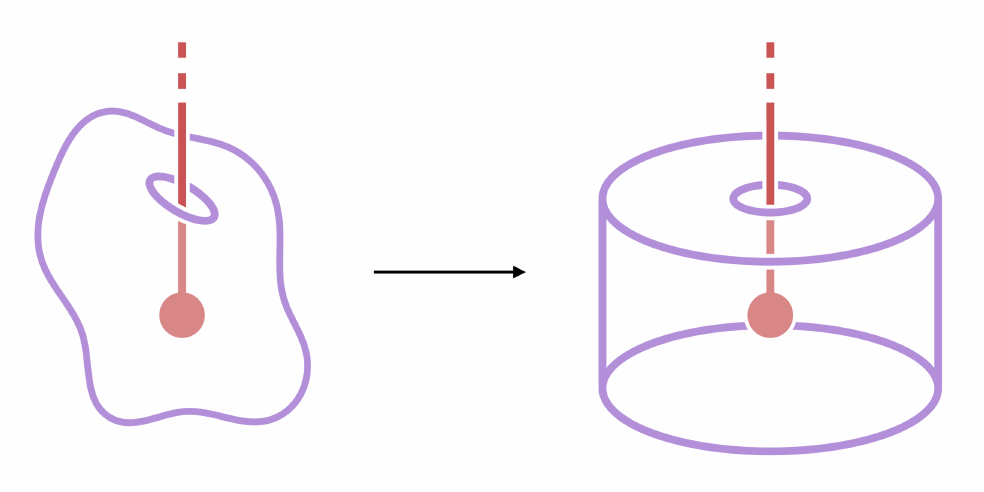
Figure 2 . Instanton charge around a creation